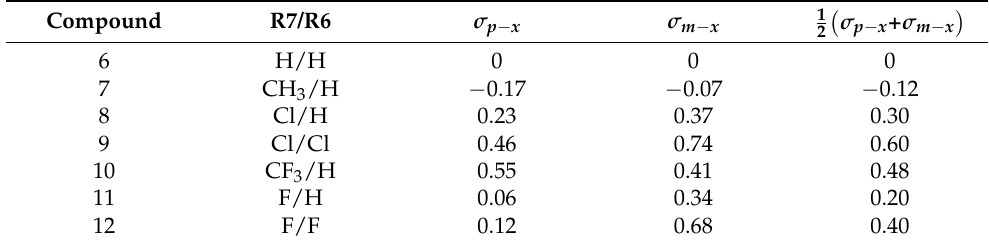
Table 4. Hammett substituent constants [41].